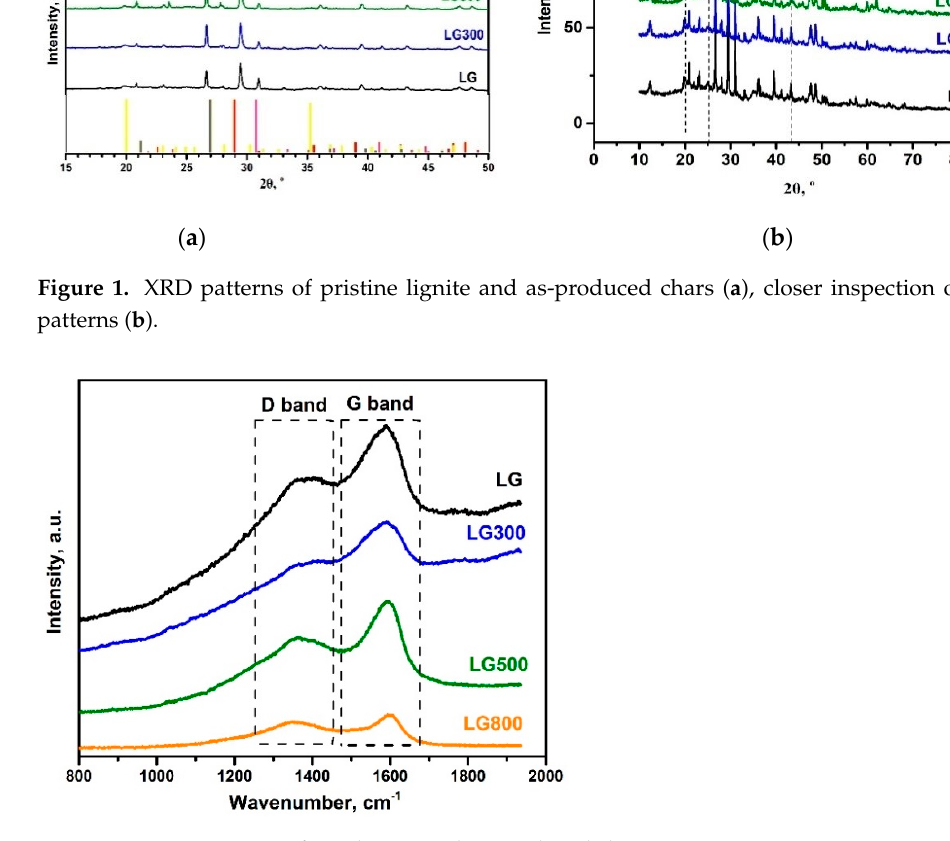
Figure 2. Raman spectra of raw lignite and as-produced chars.